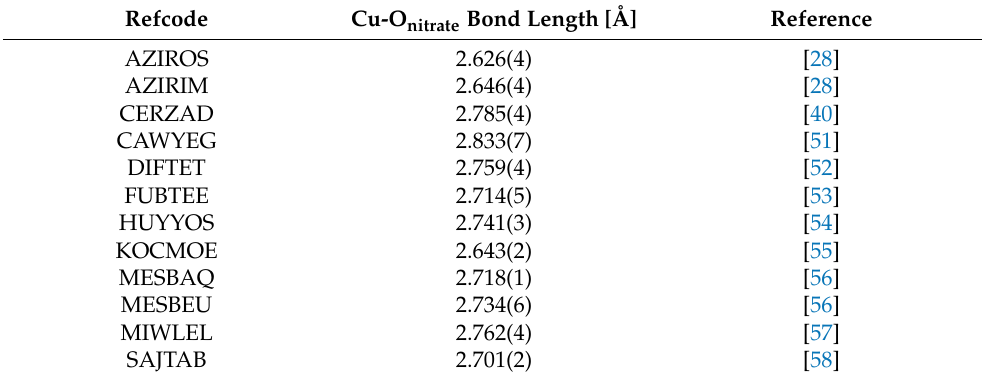
Table 4. The values of a long Cu-O nitrate bond length [50].